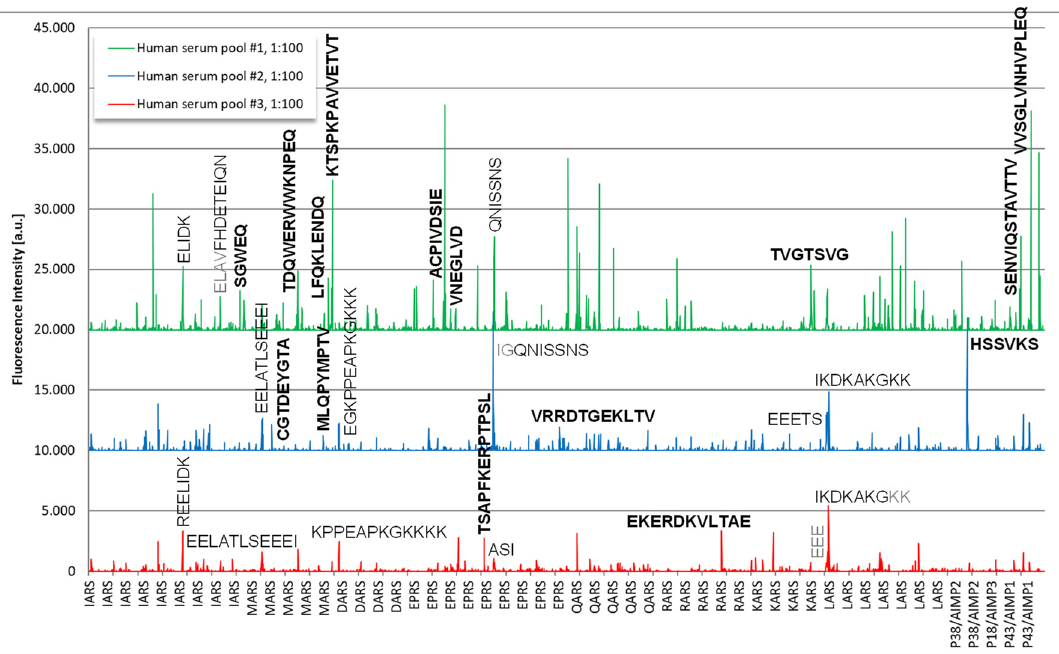
Figure 6. Epitope mapping of anti-OJ antibodies using solid phase peptide arrays. Legend: The se- quences of antigens IARS, MARS, DARS, EPRS, QARS, RARS, KARS, LARS, P38/AIMP2, P18/AIMP3 and P43/AIMP1 were synthesized as 15mer amino acid peptides with a peptide to peptide overlap of 13 amino acids. Several immunoreactive peptides were found and their sequences are indicated in the figure. Major consensus sequences are shown in bold.